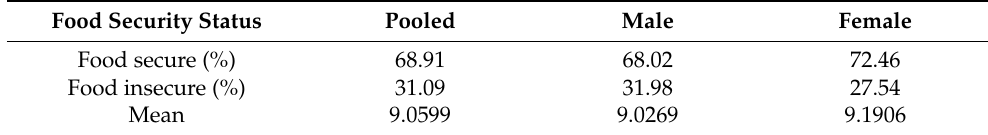
Table 8. Food insecurity status of households.